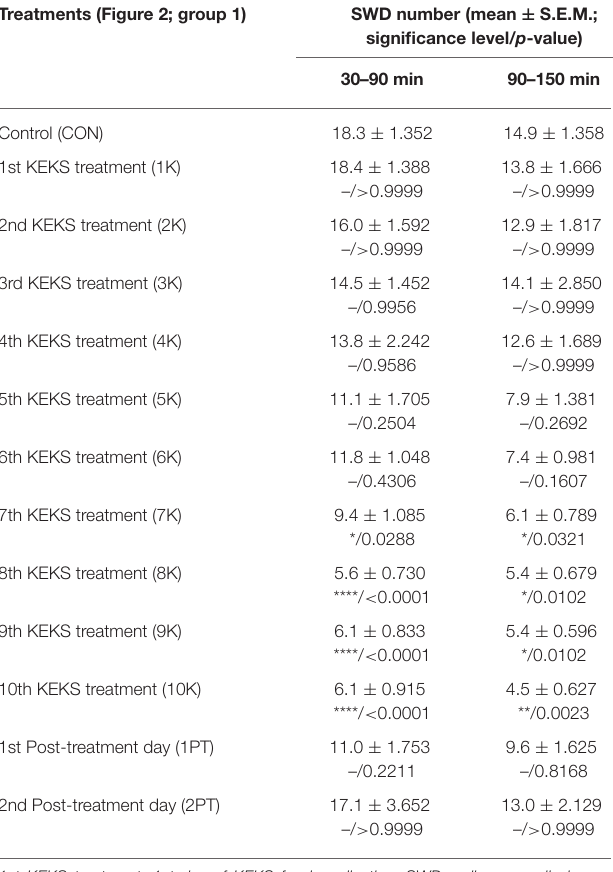
TABLE 1 | Effect of KEKS food (20% KEKS and 1% saccharin in standard rodent chow; Figure 2 , group 1) on SWD number. Treatments (Figure 2; group